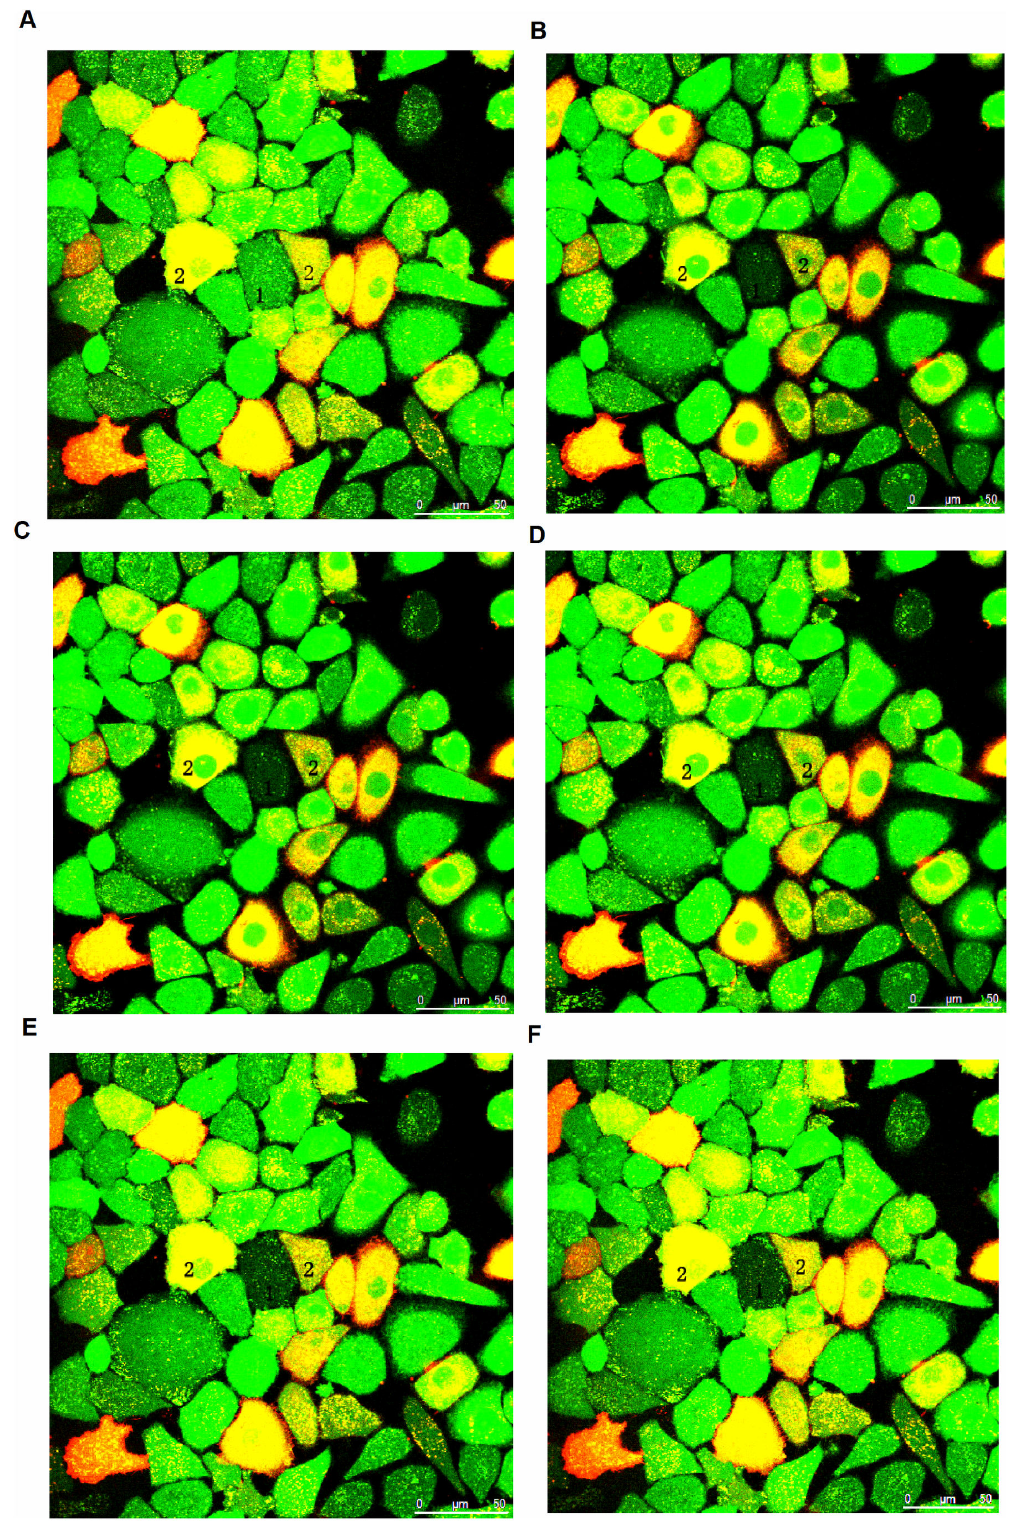
Figure 3. Fluorescence recovery images after photobleaching. 1.photobleaching mesothelial cells; 2.adjacent gastric cancer cells. A, before bleaching; B, C, D, E, F representing images in 0, 1, 2, 3, 4min after photobleaching, respectively. doi: 10.1371/journal.pone.0074527.g003 PLOS ONE |